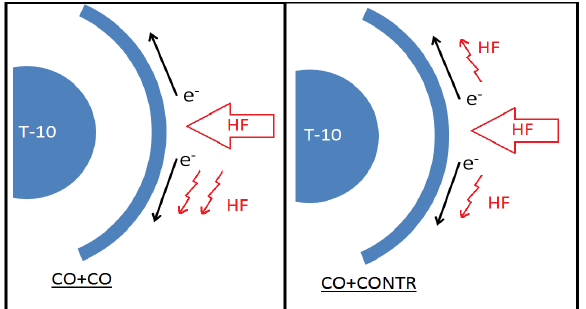
Fig. 2. Two types of HF